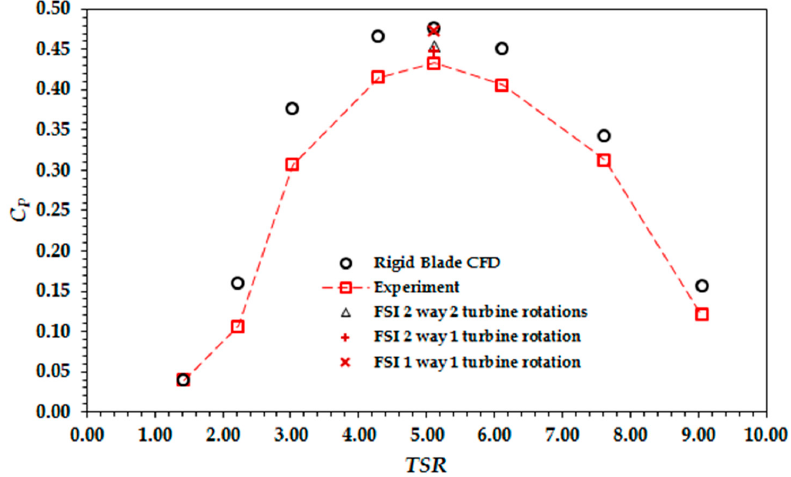
Figure 2. Performance evaluation of turbine with different modelling techniques.